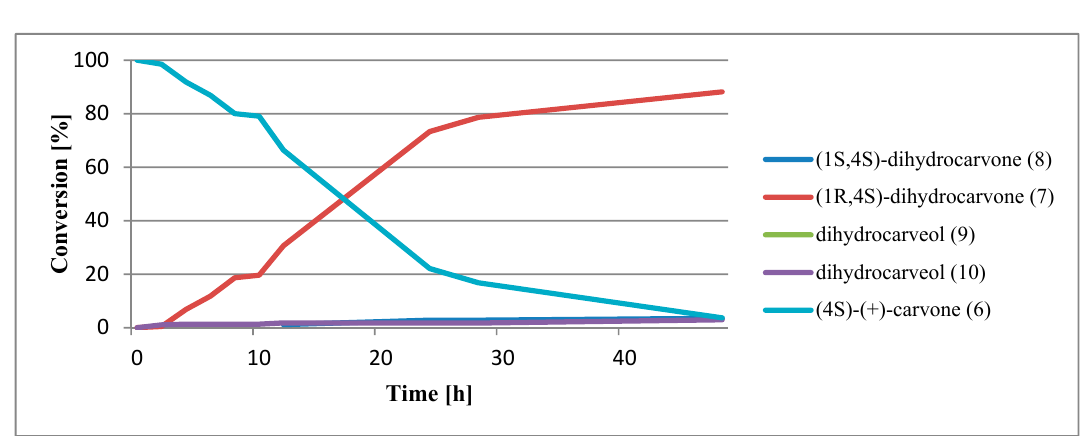
Figure 6. Biotransformation of (4 S )-(+)-carvone ( 6 ) via a comminuted potato.